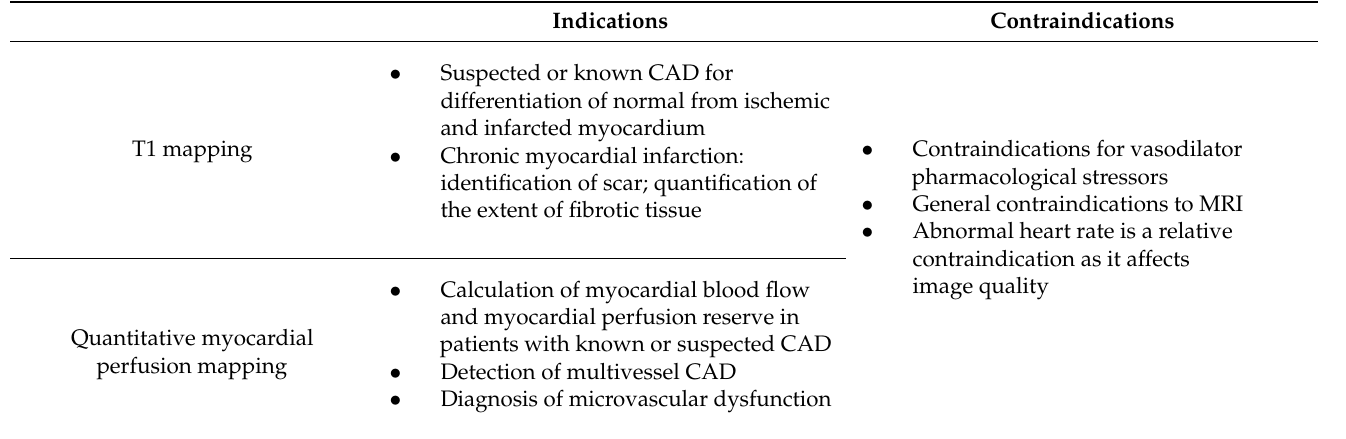
Table 1. Indications and contraindications of novel parametric mapping techniques in